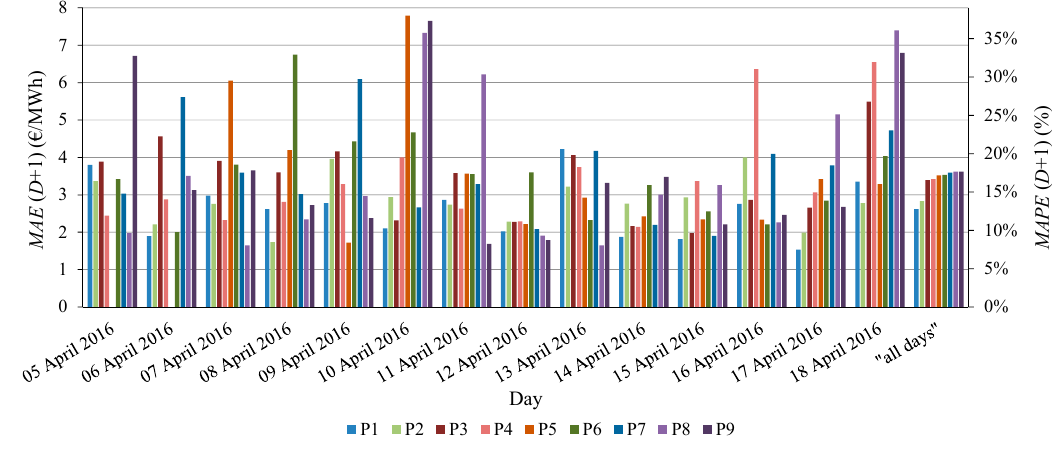
Figure 7. Values of MAE ( D + 1) and MAPE ( D + 1) for each day of the competition period and values of MAE for “all days” of the competition period, MAE g ( D + 1), for the best nine predictors. The performances of the first and second best ranked predictors (P1 and P2) for “all days” of the competition period (with MAE g ( D + 1 ) of 2.6 and 2.8 € /MWh, respectively), are better than those